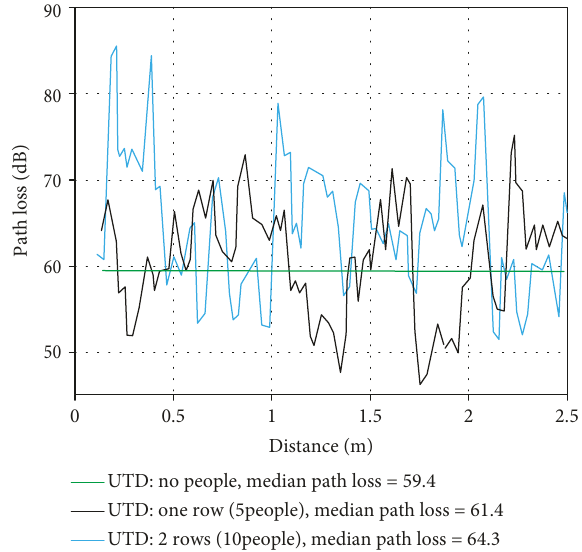
Figure 14: The results of path loss simulation for the case where there were no people, 5 people in one row, and 10 people in 2